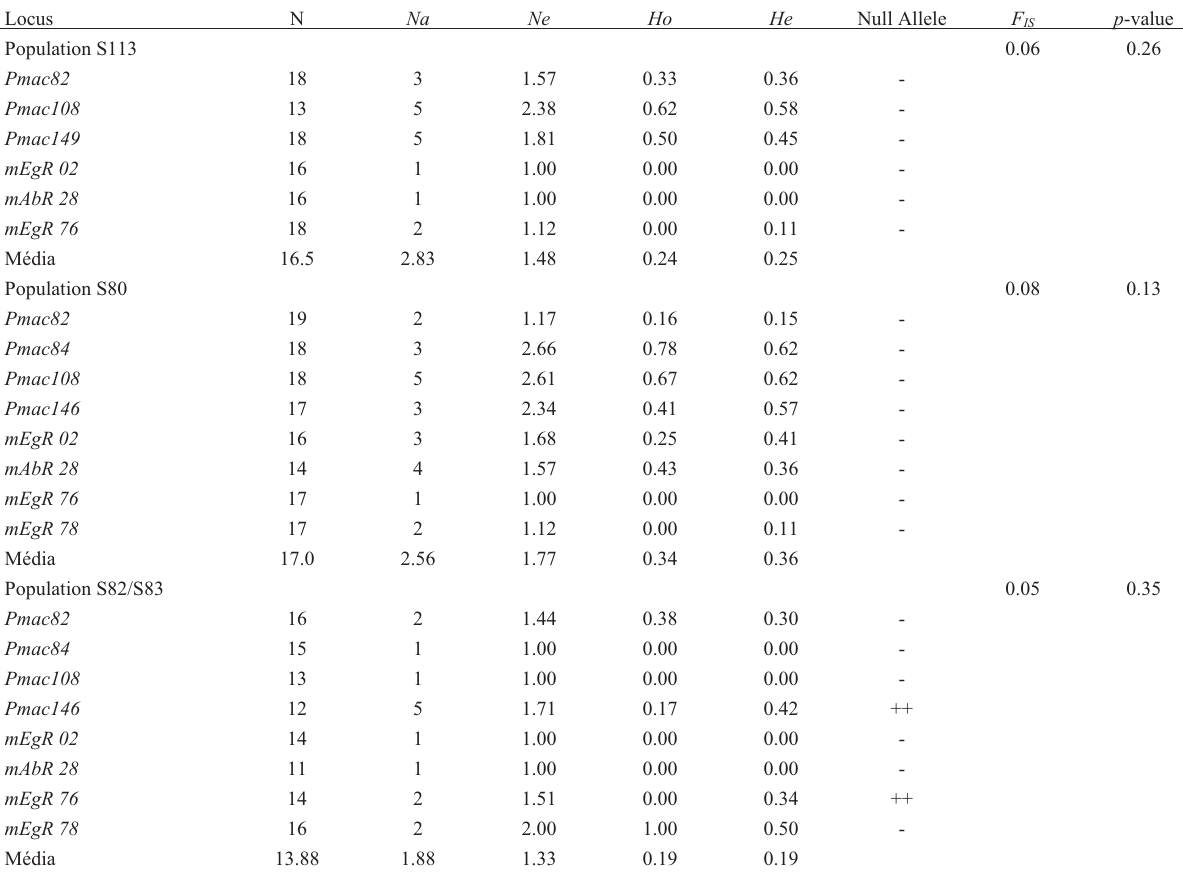
Table 2 - Genetic diversity indices: Number of samples (N), Number of alleles ( Na ), Effective allele number ( Ne ), Observed heterozygosity ( Ho ), Ex- pected heterozygosity ( He ), absence (-) and presence (+) of null alleles, and F IS values per loci and population are shown. Locus N Na Ne Population S113